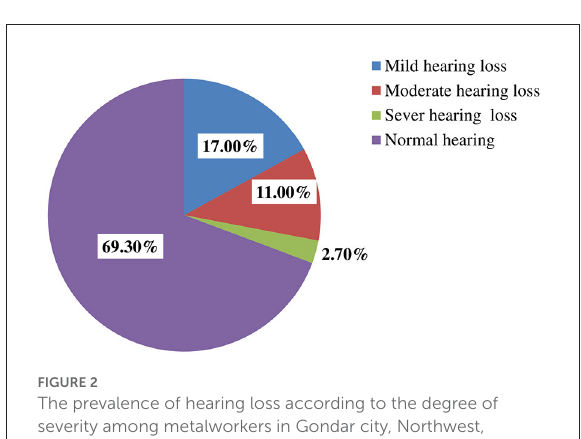
FIGURE2 The prevalence of hearing loss according to the degree of severity among metalworkers in Gondar city, Northwest,